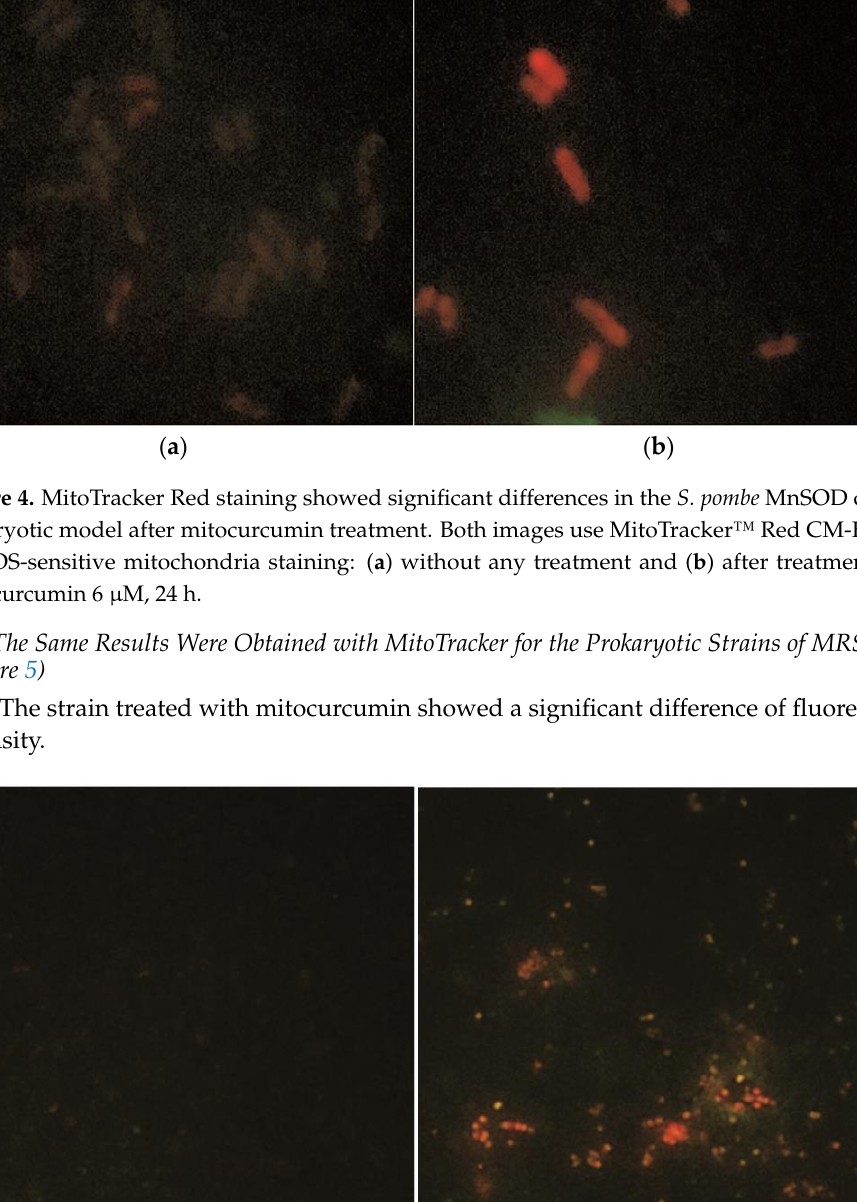
Figure 3. Curcumin (blue) and mitocurcumin (red) spectra at the same concentration (10 µM).